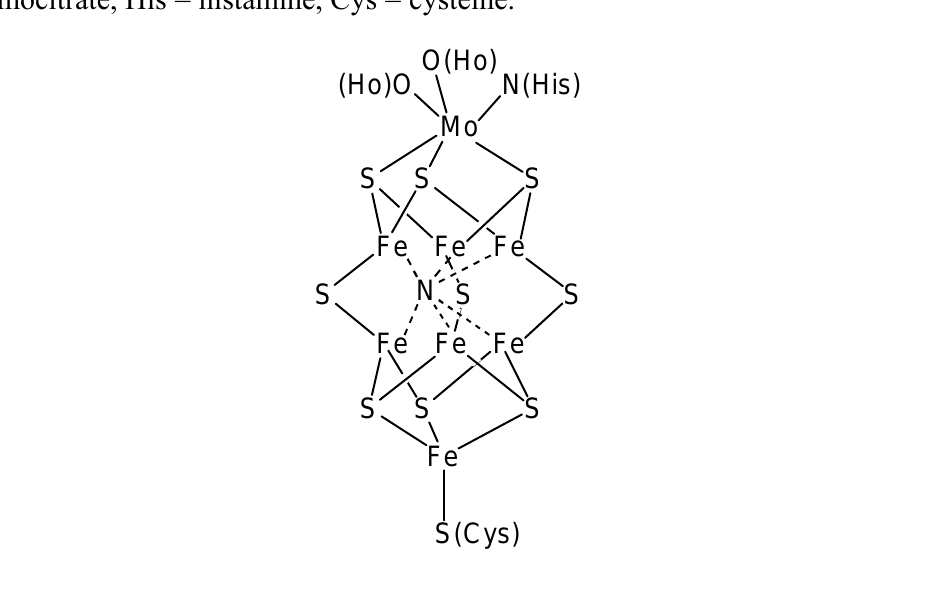
Figure 1. Model of the FeMo cofactor of nitrogenase adapted from Smith [4]. Ho = homocitrate, His = histamine, Cys =